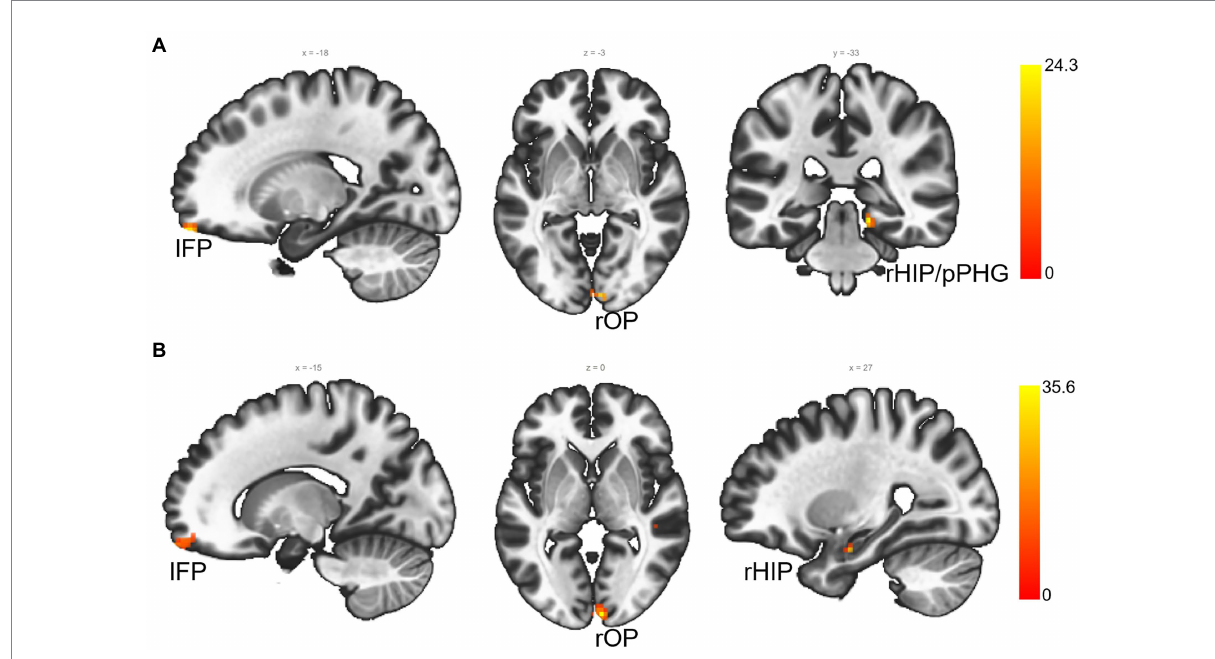
FIGURE 2 The FC-MVPA that predicts rTMS treatment outcomes at baseline (voxel p < 0.001, cluster-size FDR corrected p < 0.05). (A) ROIs that predict SIB changes from rTMS; (B) ROIs that predict CIBIC-Plus changes from rTMS. lFP, left frontal pole; rOP, right occipital pole; right hippocampus/ posterior parahippocampal gyrus (rHIP/pPHG); rHIP, right